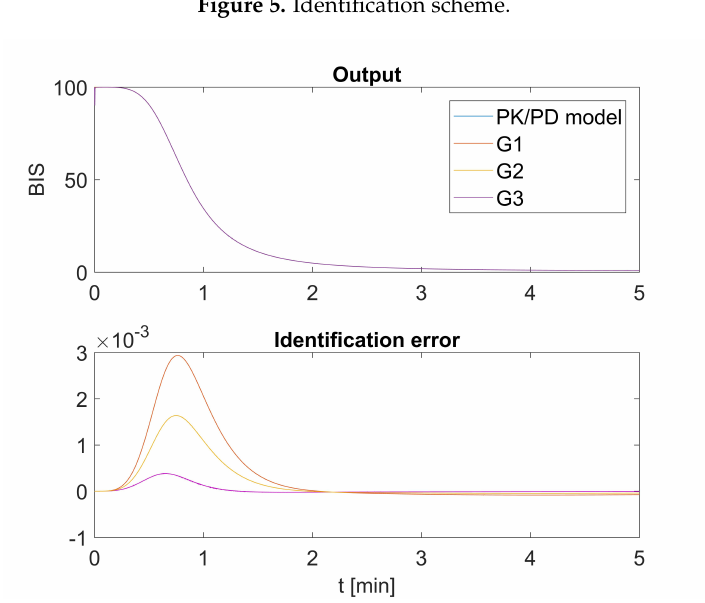
Figure 6. Identification, bispectral index (BIS) output of the PK/PD model and the proposed fractional-order model